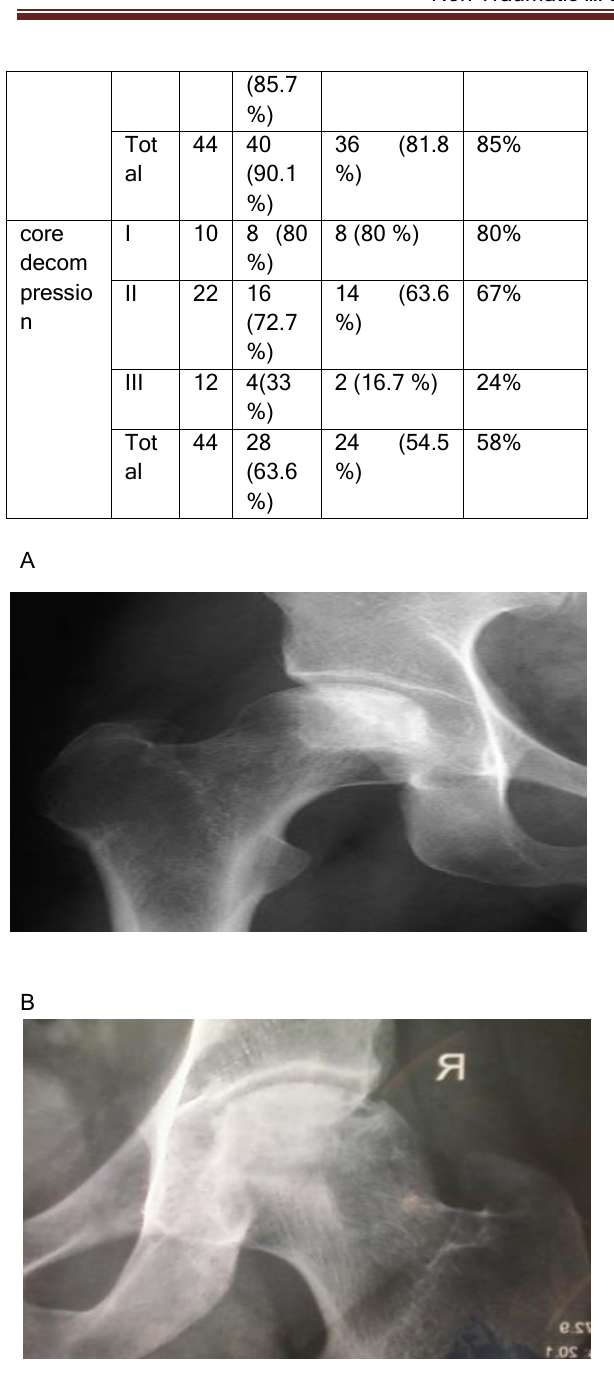
Fig 3: A: stage II AVN B: result after 1year